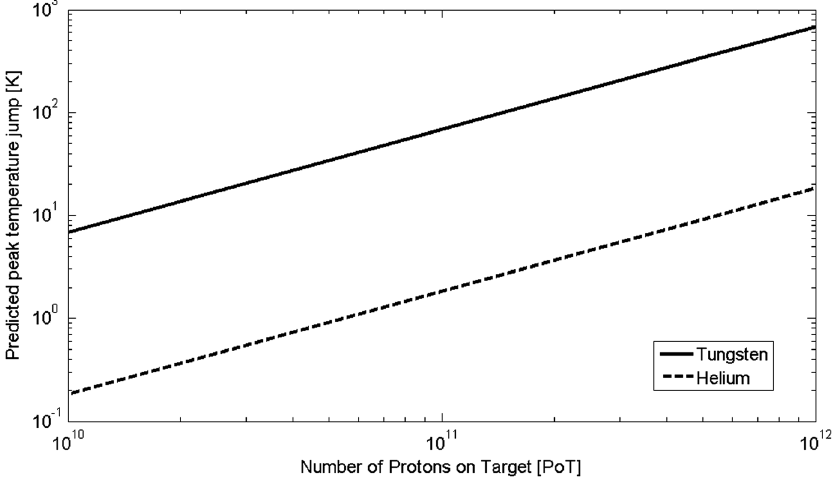
FIG. 8. Predicted maximum temperature jump assuming constant heat capacity and beam sigma of 2